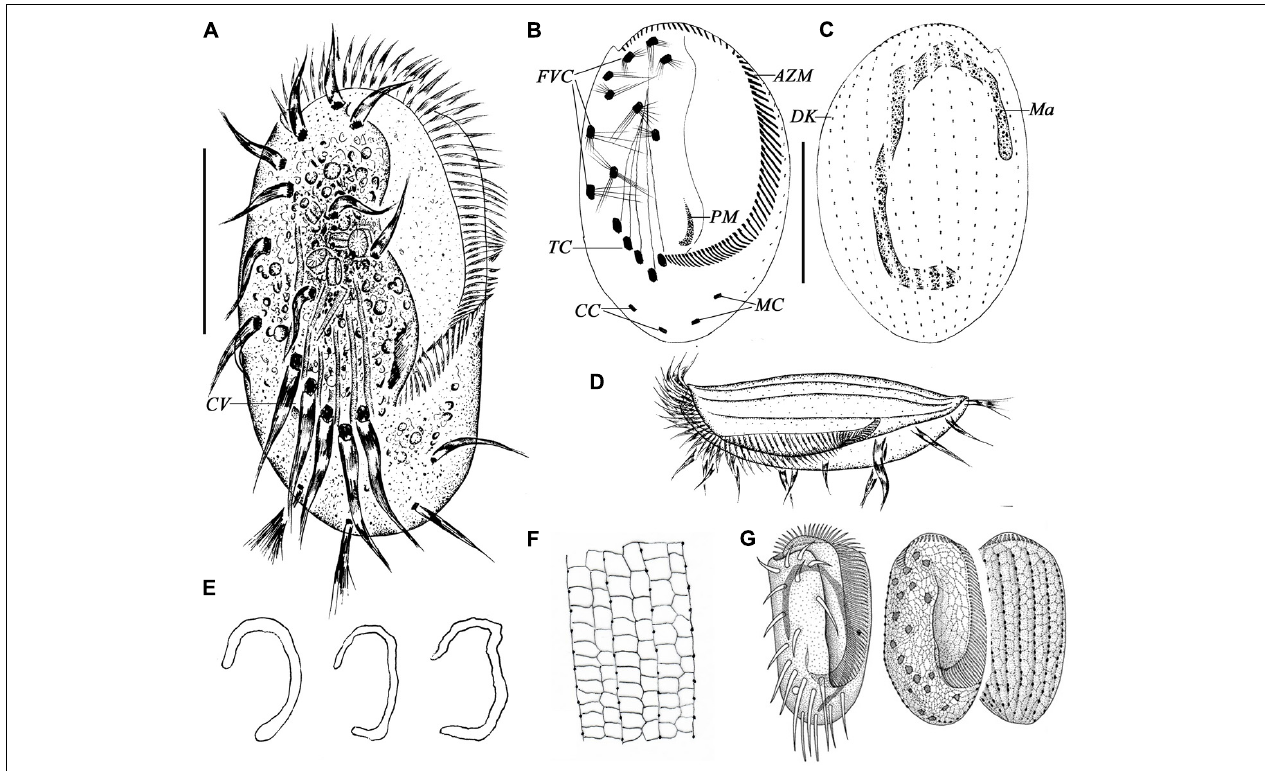
FIGURE 1 | Morphology of Euplotes neapolitanus Wichterman, 1964 in vivo (A,D) , after protargol (B,C,E) and silver nitrate impregnation (F,G) . (A) Ventral view of a representative specimen. (B,C) Ventral (B) and dorsal (C) view of the same specimen showing the ciliary pattern and nuclear apparatus. (D) Left lateral view showing the AZM and the dorsal ridges. (E) Different shapes of macronucleus. (F) Details of the silverline system of dorsal side. (G) Silverline system on ventral and dorsal sides, from Wichterman (1964). AZM, adoral zone of membranelles; CC, caudal cirri; CV, contractile vacuole; DK, dorsal kinety; FVC, frontoventral cirri; Ma, macronucleus; MC, marginal cirri; PM, paroral membrane; TC, transverse cirri. Scale bars = 50 µ